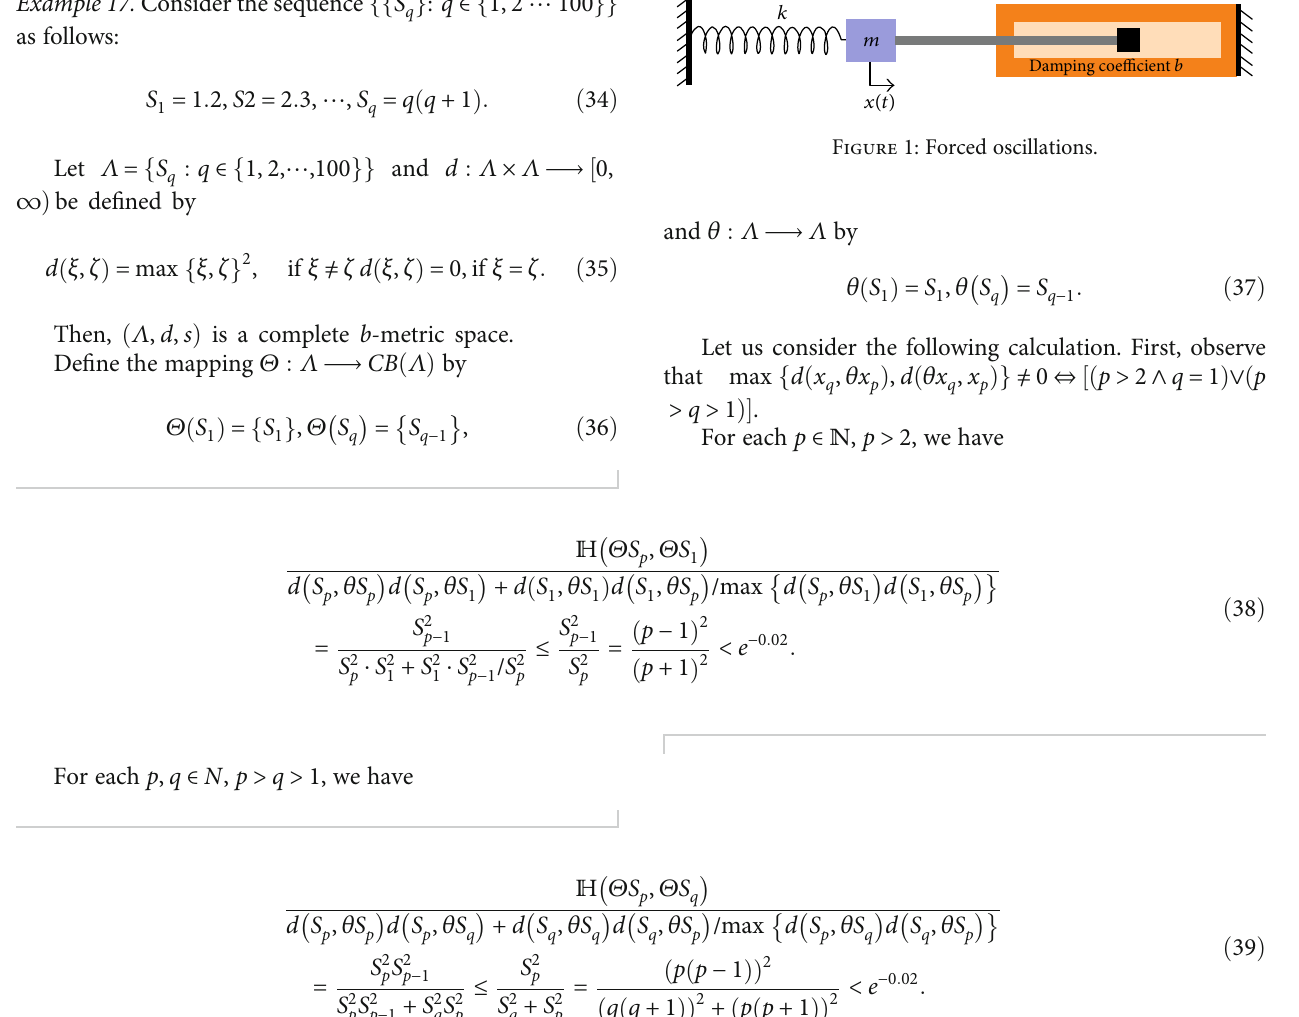
Figure 1: Forced